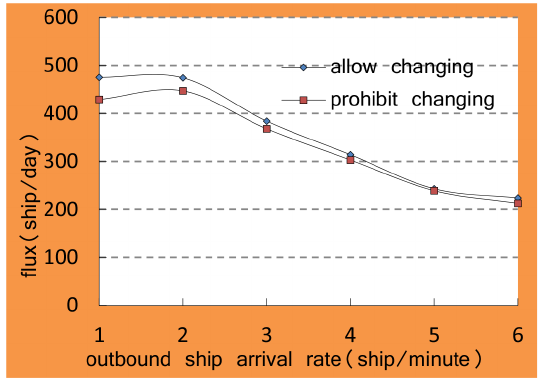
Figure 12. Traffic flux of waterway system and ship arrival rate as a function (inbound ship arrival rate = 1)